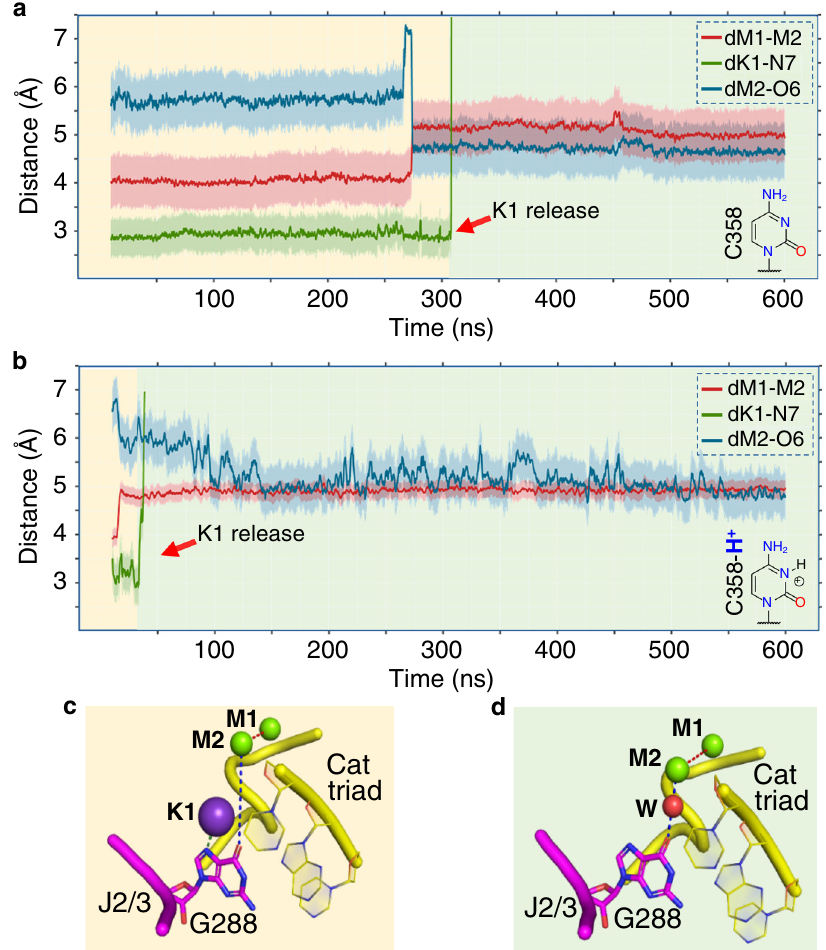
Fig. 5 Protonation of N3 C358 favors K1 release. Evolution of d M1 – M2 (red trace), d K1 – N7 (green trace), and d M2-O6 (blue trace) over the course of MD simulations of: a the cleaved state, and b the cleaved-H + state. Shading around the traces indicates the s.d. of the corresponding distance Schematic structures of non-protonated and protonated cytidine groups are depicted in the bottom right of each panel. K1 is released after ~300 ns and ~40 ns from the two states, respectively (red arrow). c Structure of the active site at the beginning of the simulations after the formation of K1 – N7 G288 . d Structure of the active site at the end of the simulations, after K1 release. K1 is released after the solvation of the active site (water molecule depicted as a red sphere,